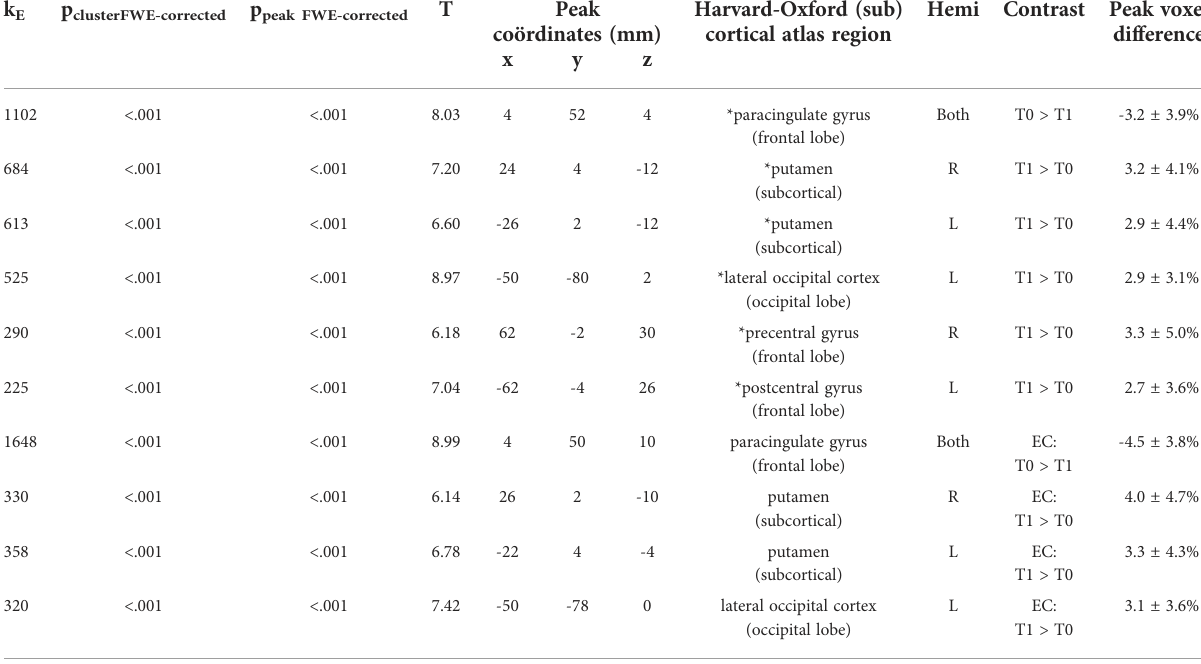
n = 282 scans of 141 subjects. Age and scanner are included in the statistical models as covariates. *Regions for which mean relative glucose metabolism was calculated for regression